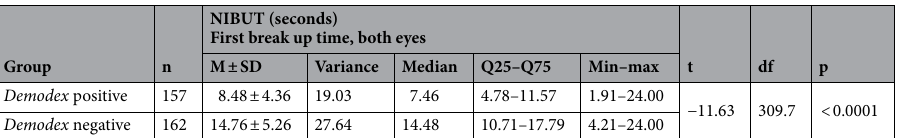
NIBUT (seconds) First break up time, both eyes